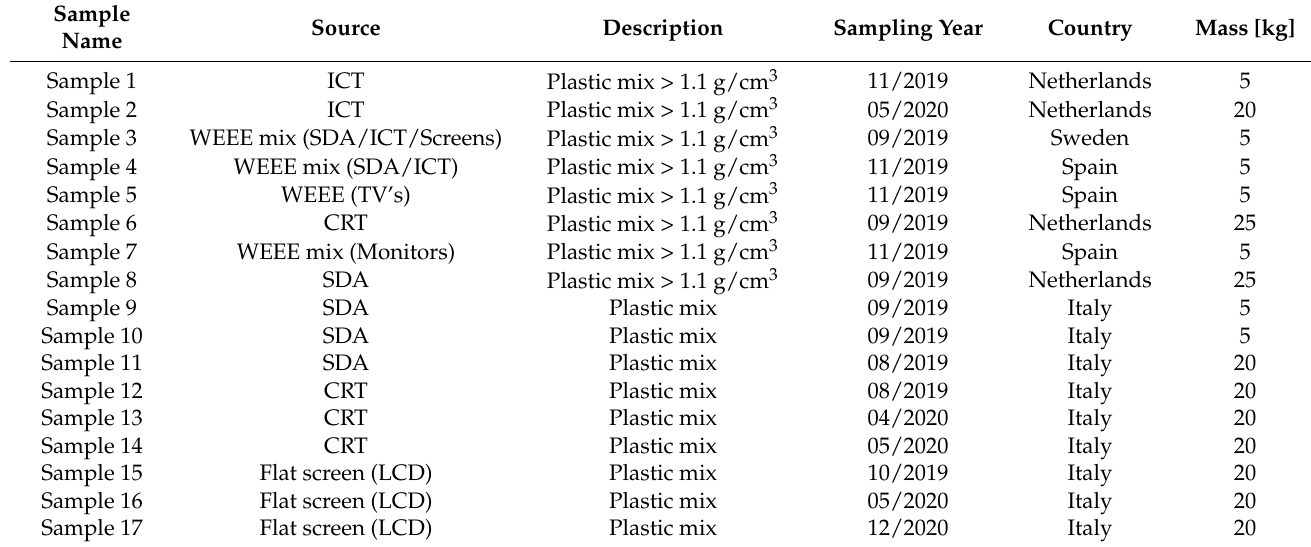
Table 1. Overview of the investigated materials, with respect to source and sampling date and country of origin.